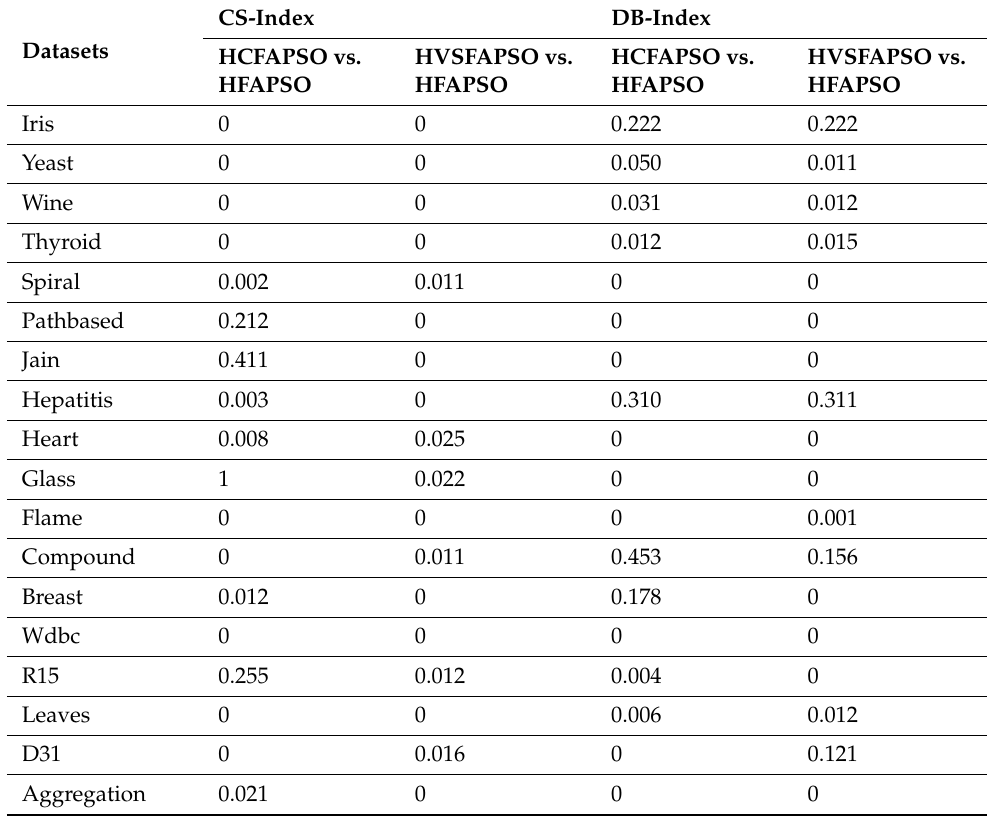
Table 7. p -Values generated by using Wilcoxon rank-sum test for equal